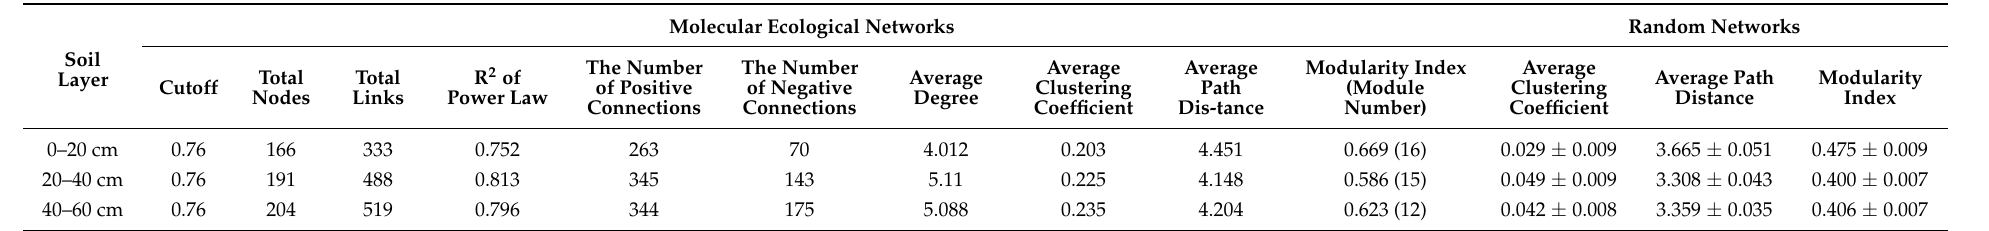
Table 2. Topological parameters of molecular ecological networks and random network of the bacterial community in the soil profiles of native tree